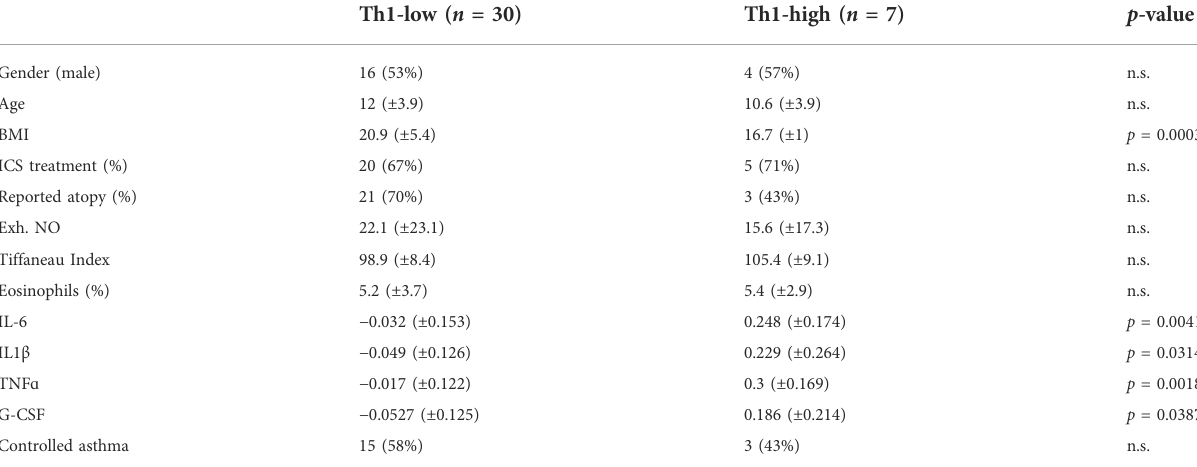
TABLE2DemographicsoftheTh1-high/lowdonorpopulation.TheTh1-highphenotypeischaracterisedbysigni fi cantlyincreasedinterleukin6(IL6), IL1b, TNFa and G-CSF level (** p < 0.01, *** p < 0.001), and a signi fi cant difference in BMI but no other patient demographics.